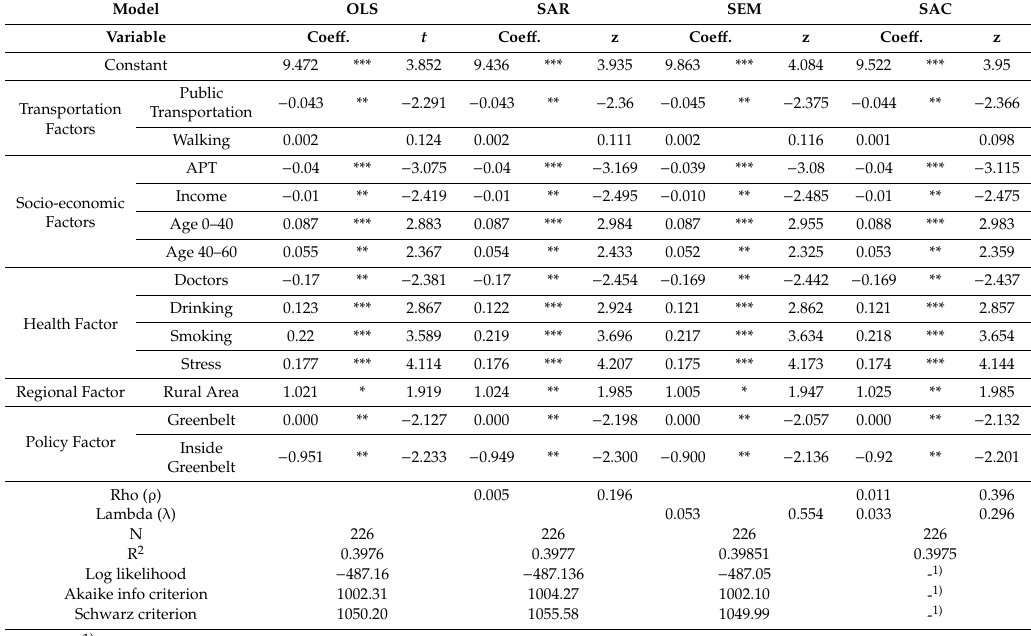
Table 4. Comparison results by model: ordinary least square (OLS), spatial autoregressive model (SAR), spatial error model (SEM), and general spatial model